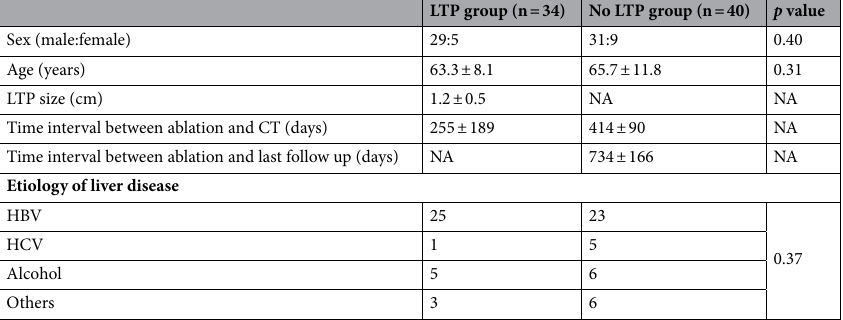
Table 1. Clinical characteristics of the 74 study patients. LTP, local tumor progression; CT, computed tomography; NA, not applicable; HBV, hepatitis B virus; HCV, hepatitis C virus.